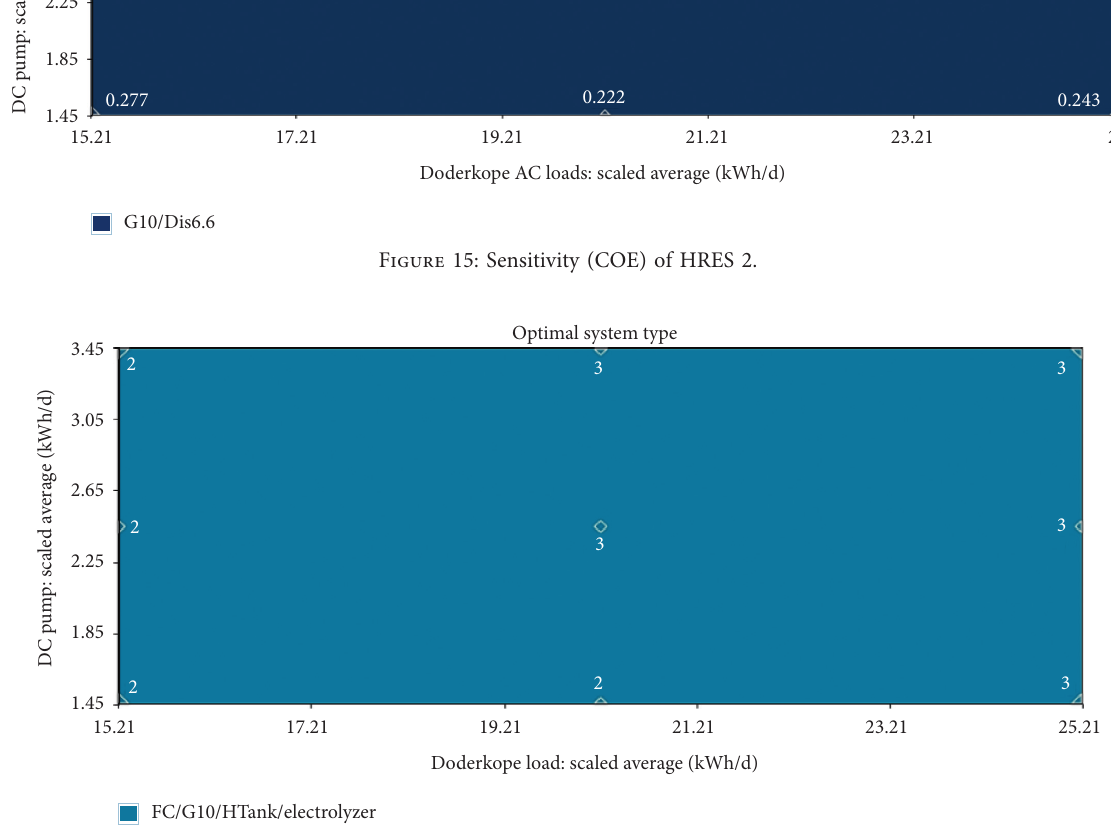
Figure 16: Sensitivity (G10) of HRES 1.